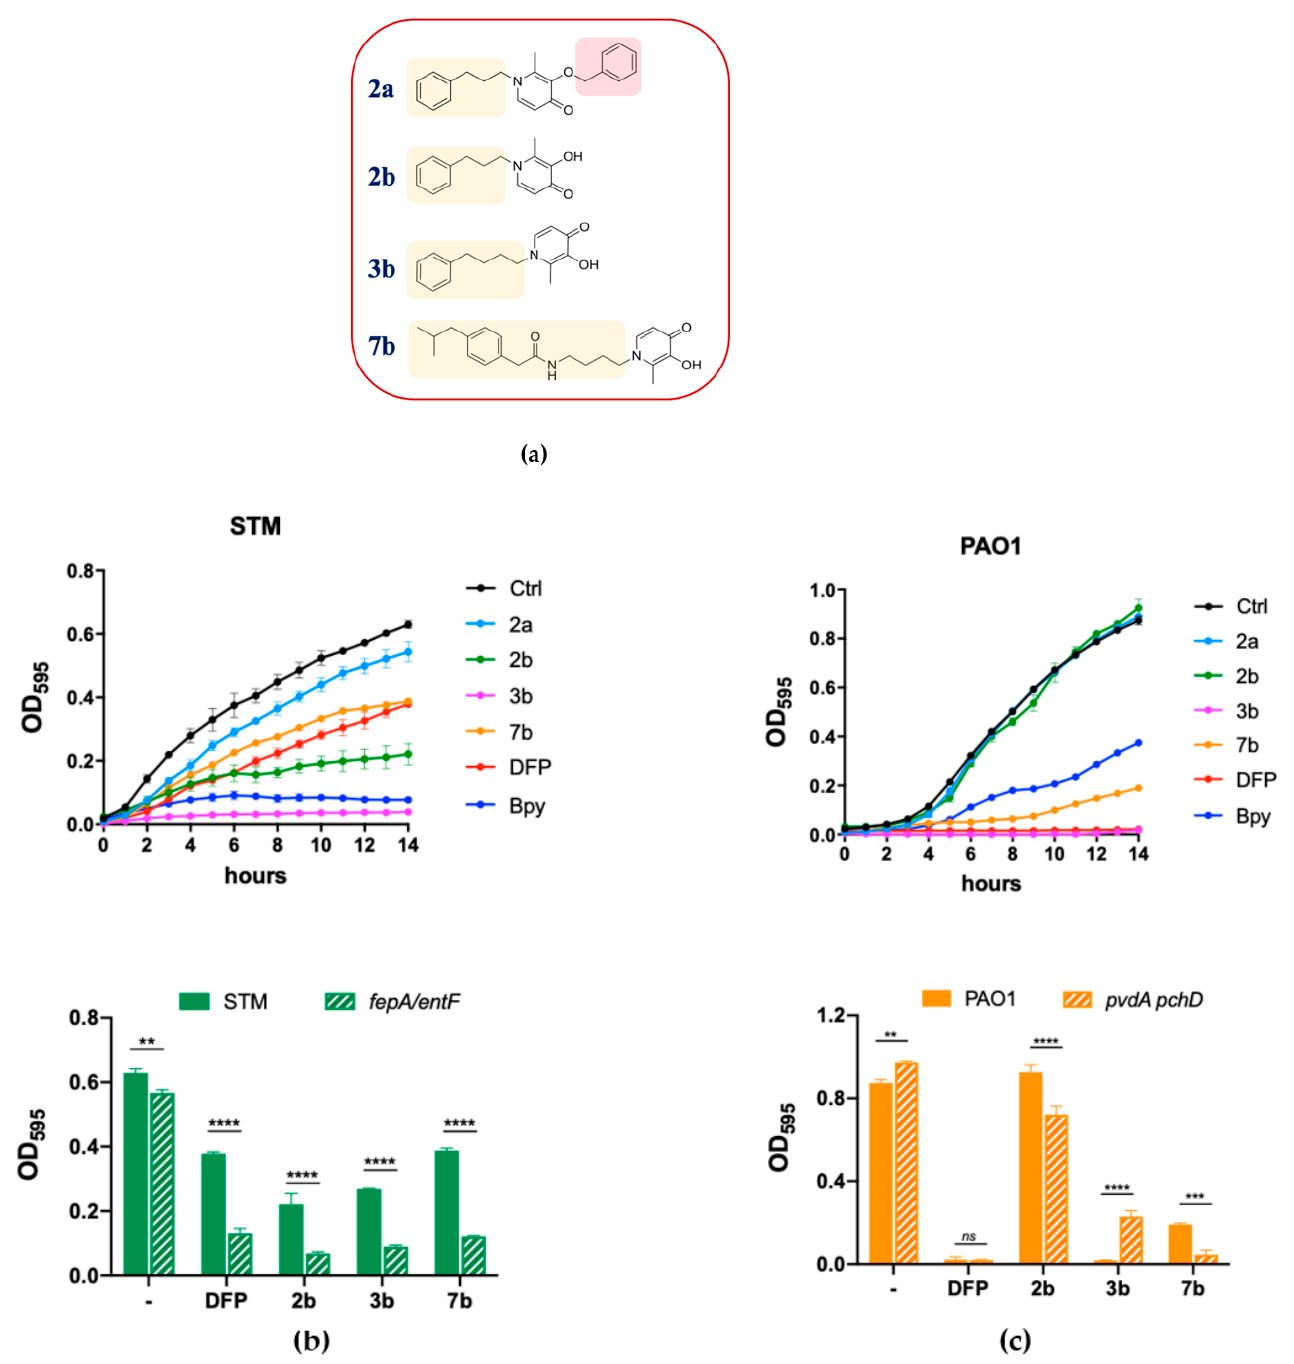
Figure 4. Effects of DFP derivatives on bacterial growth. ( a ) Molecular structures of the compounds selected for this study; the chemical moieties added to DFP are highlighted. ( b ) Effect on STM growth. In the upper graph the growth curves of STM in LB (Ctrl) supplemented with compounds 2a, 2b, 3b, 7b, DFP (2 mM) or Bpy (0.2 mM) are shown; in the lower graph the optical densities of STM (wild type) and fepA/entF mutant, after 14 h of growth in LB ( − ) supplemented with DFP, 2b, 3b or 7b (2 mM), are compared. ( c ) Effect on PAO1 growth. In the upper graph the growth curves of PAO1 in LB (Ctrl) supplemented with compounds 2a, 2b, 3b, 7b, DFP (2 mM) or Bpy (0.2 mM) are shown; in the lower graph the optical densities of PAO1 (wild type) and pchD pvdA mutant, after 14 h of growth in LB (-) supplemented with DFP, 2b, 3b or 7b (2 mM), are compared. Statistical significance (two-way ANOVA and Sidak’s multiple comparisons test): ** p < 0.01; *** p < 0.005; **** p < 0.0001, ns